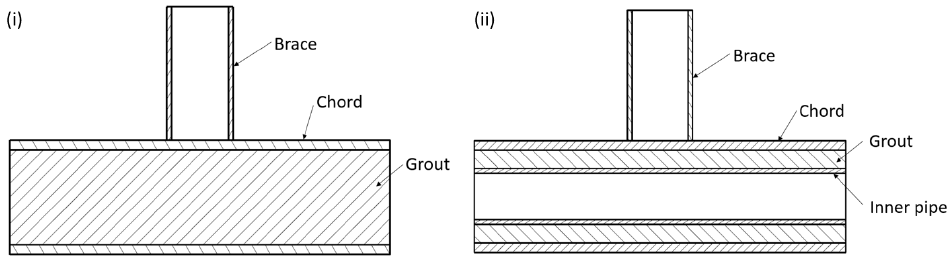
Figure 7. Grouted T-joint. ( i ) Solid grouted, ( ii ) annular